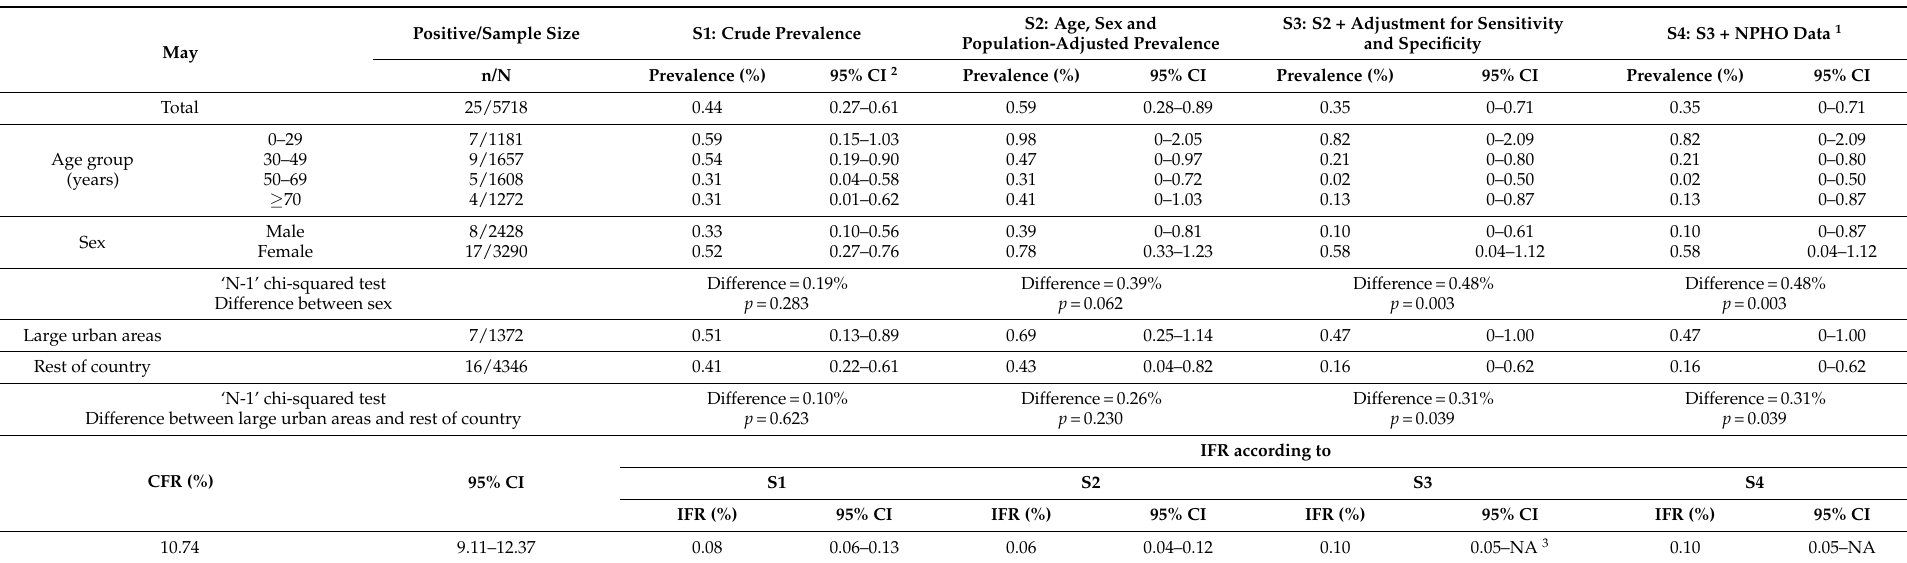
Table 1. Anti-SARS-CoV-2 IgG antibody seroprevalence, Greece, May 2020 ( n =